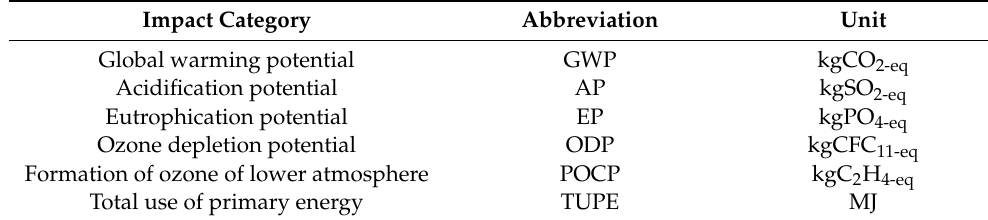
Table 1. Adopted impact categories.